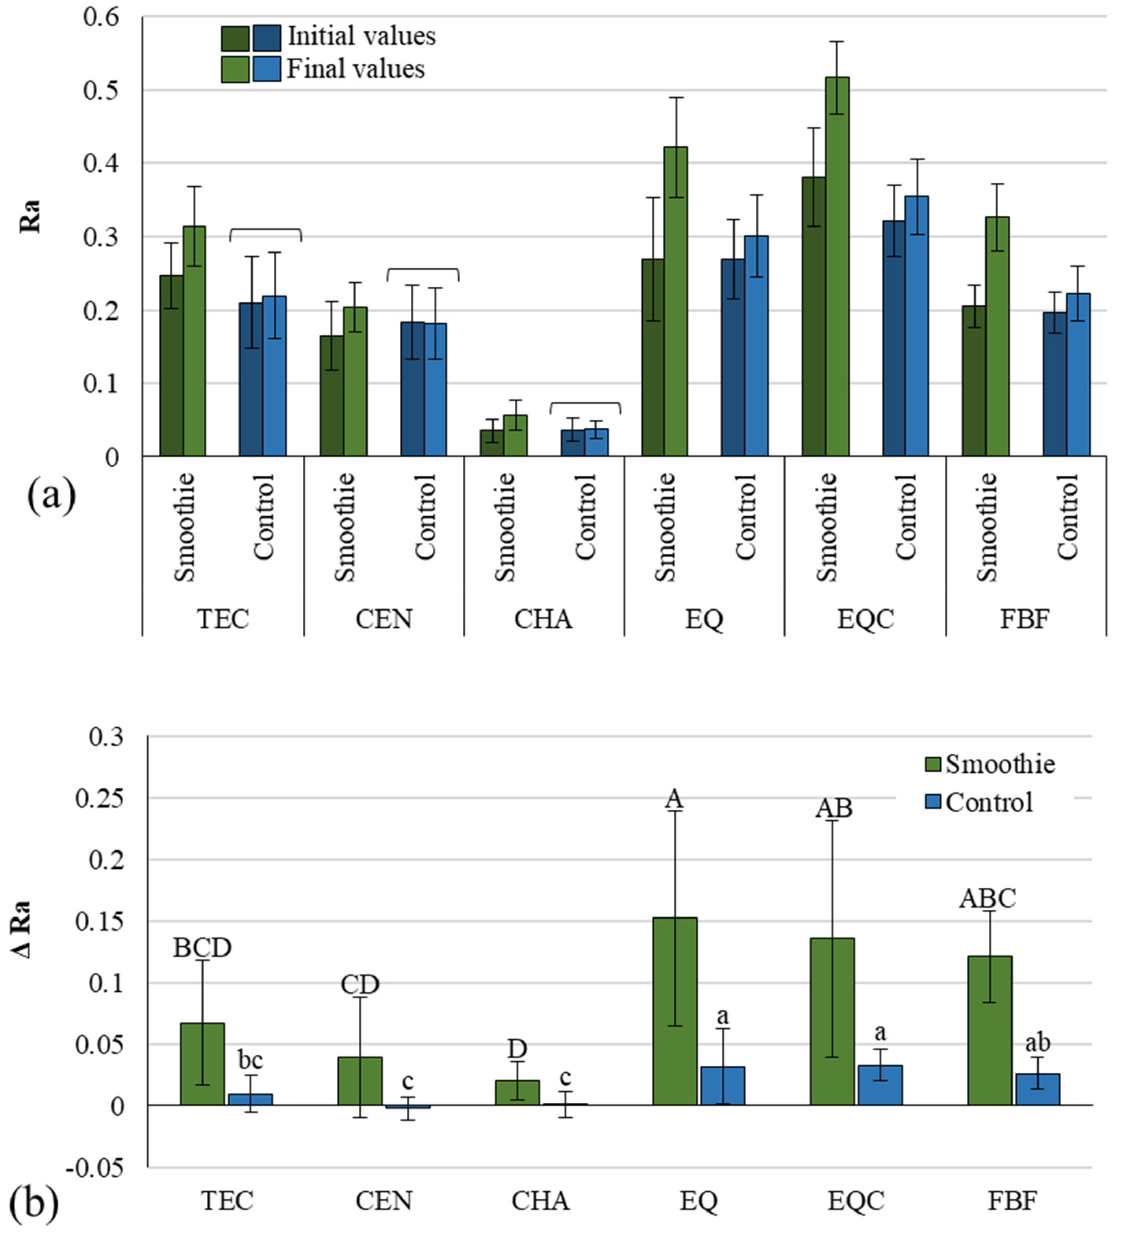
Figure 3. Profile roughness represented as Ra (mean values ± 1 standard deviation, n = 10) measured 24 h after specimen preparation and after 1 month of immersion ( a ), and delta Ra (mean values ± s.d.) representing profile roughness change between these two time points ( b ). Square brackets indicate statistically similar values. All pairwise comparisons (smoothie vs. control) of delta Ra values showed statistically significant differences. Same uppercase letters indicate statistically similar values within the smoothie group. Same lowercase letters indicate statistically similar values within the control group. TEC: Tetric EvoCeram, CEN: Cention, CHA: Charisma Classic, EQ: Equia Forte HT Fil Uncoated, EQC: Equia Forte HT Fil Coated FBF: Filtek Bulk